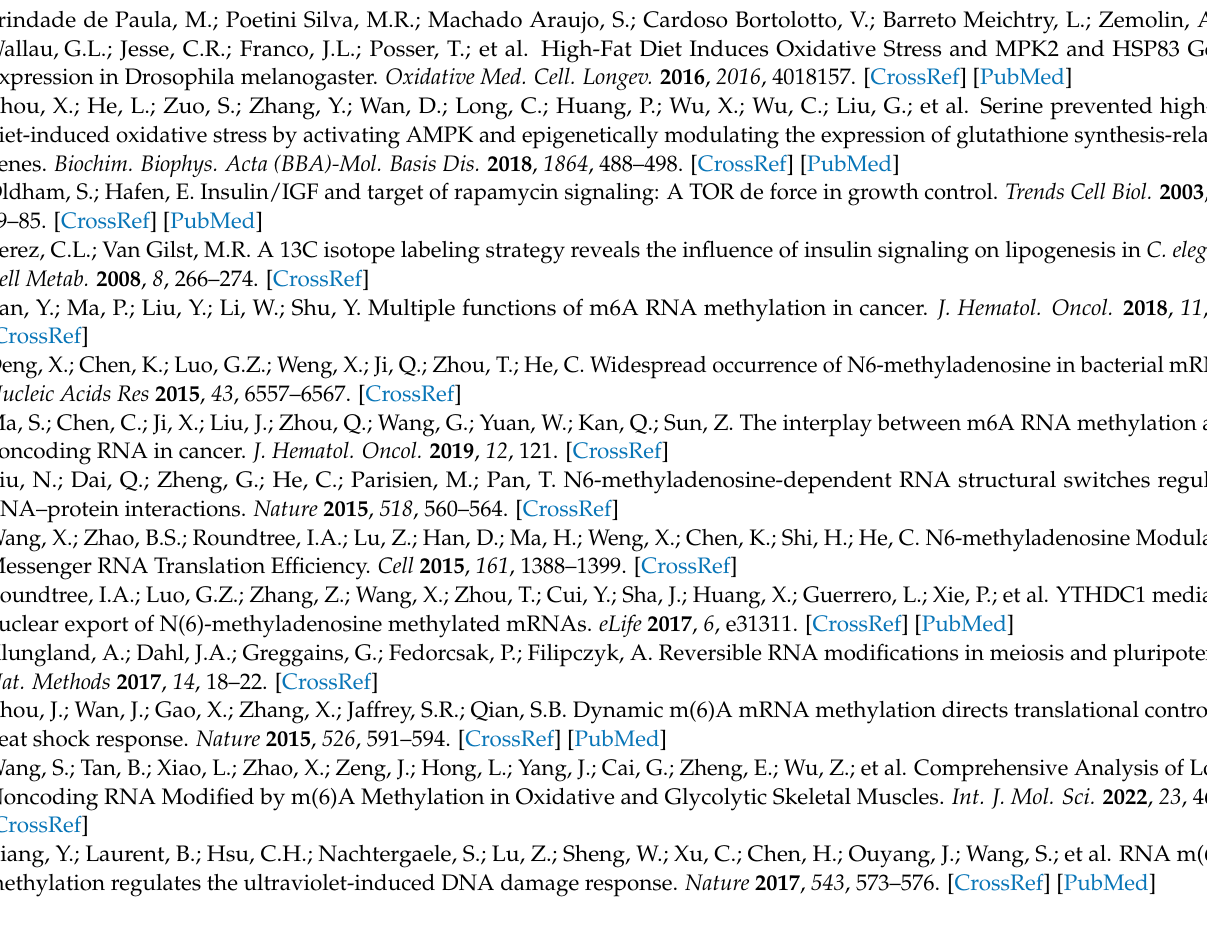
Figure S2: Flow cytometry detection graphs; Table S1: Distribution of m6A peaks; Table S2: Statistics of the number of differentially methylated genes; Table S3: Peaks distribution statistics of differentially methylated genes; Table S4: Transcription level change statistics; Table S5: Statistics of changes in methylation level and transcription level; Table S6: Changes in the methylation level and transcription level of Camk1db